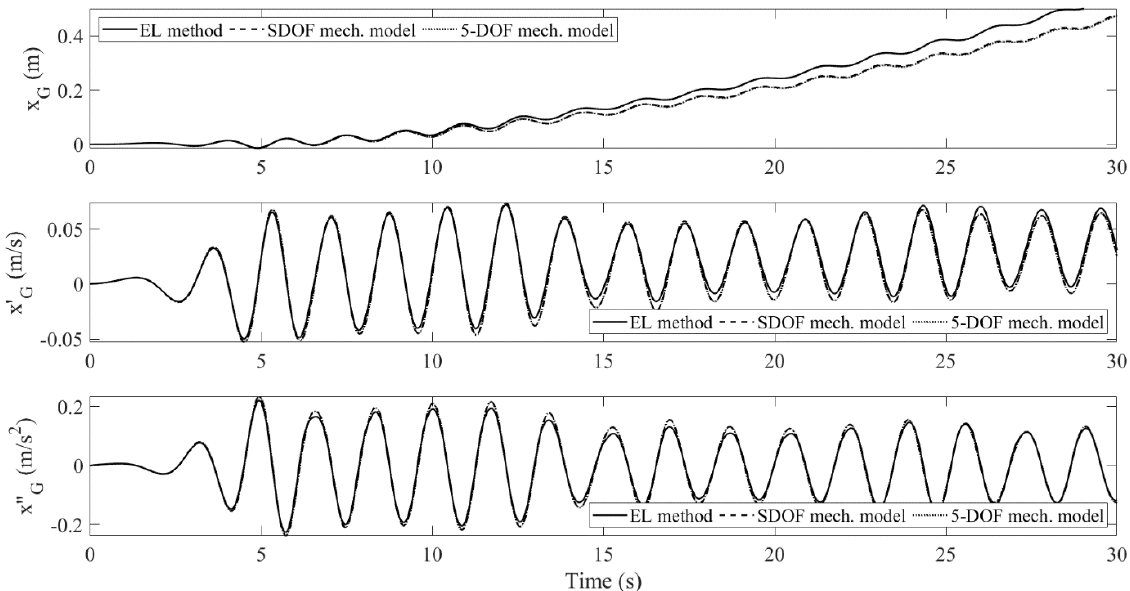
Figure 8. The surge motion responses of the floating body, configured with a water tank installed with porous media, undergoing large wave excitation.